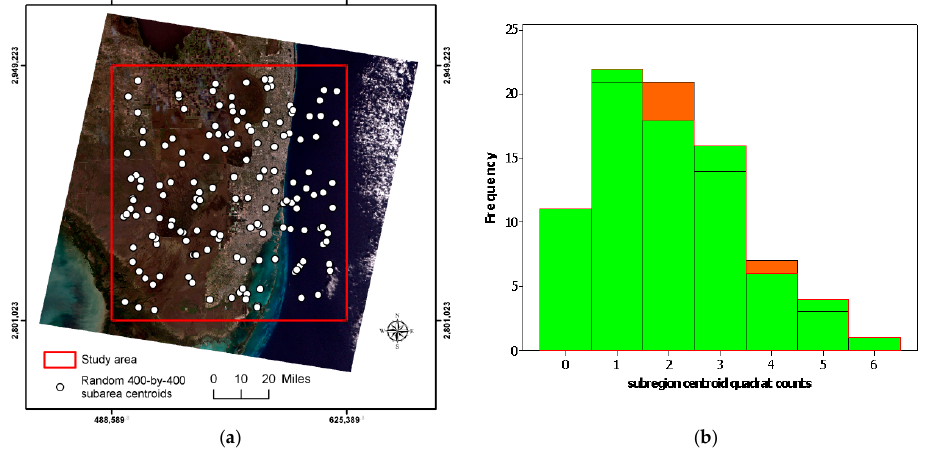
Figure 6. Features of the random sample of sub-regions. ( a ) the geographic distribution of the sub-region centroids; and ( b ) a histogram comparison between observed (green) and theoretical Poisson (red and black lines for hidden bars) quadrat counts.